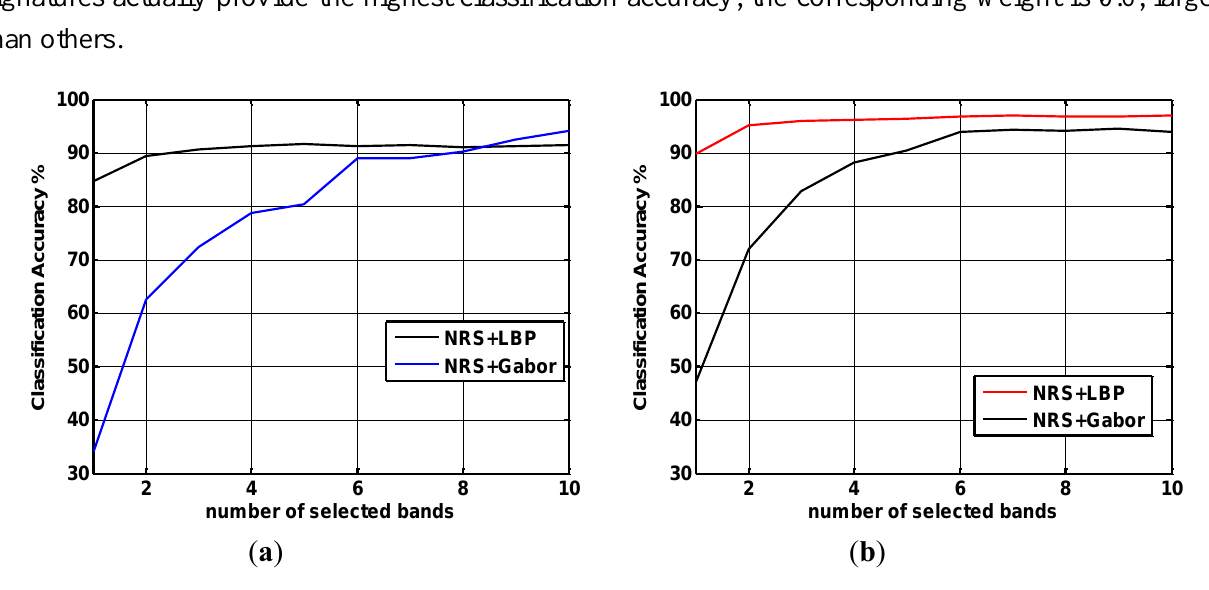
Figure 4 . Classification accuracy versus the number of selected bands for: ( a ) University of Pavia dataset (60 training samples per class); ( b ) Salinas dataset (30 training samples per class).